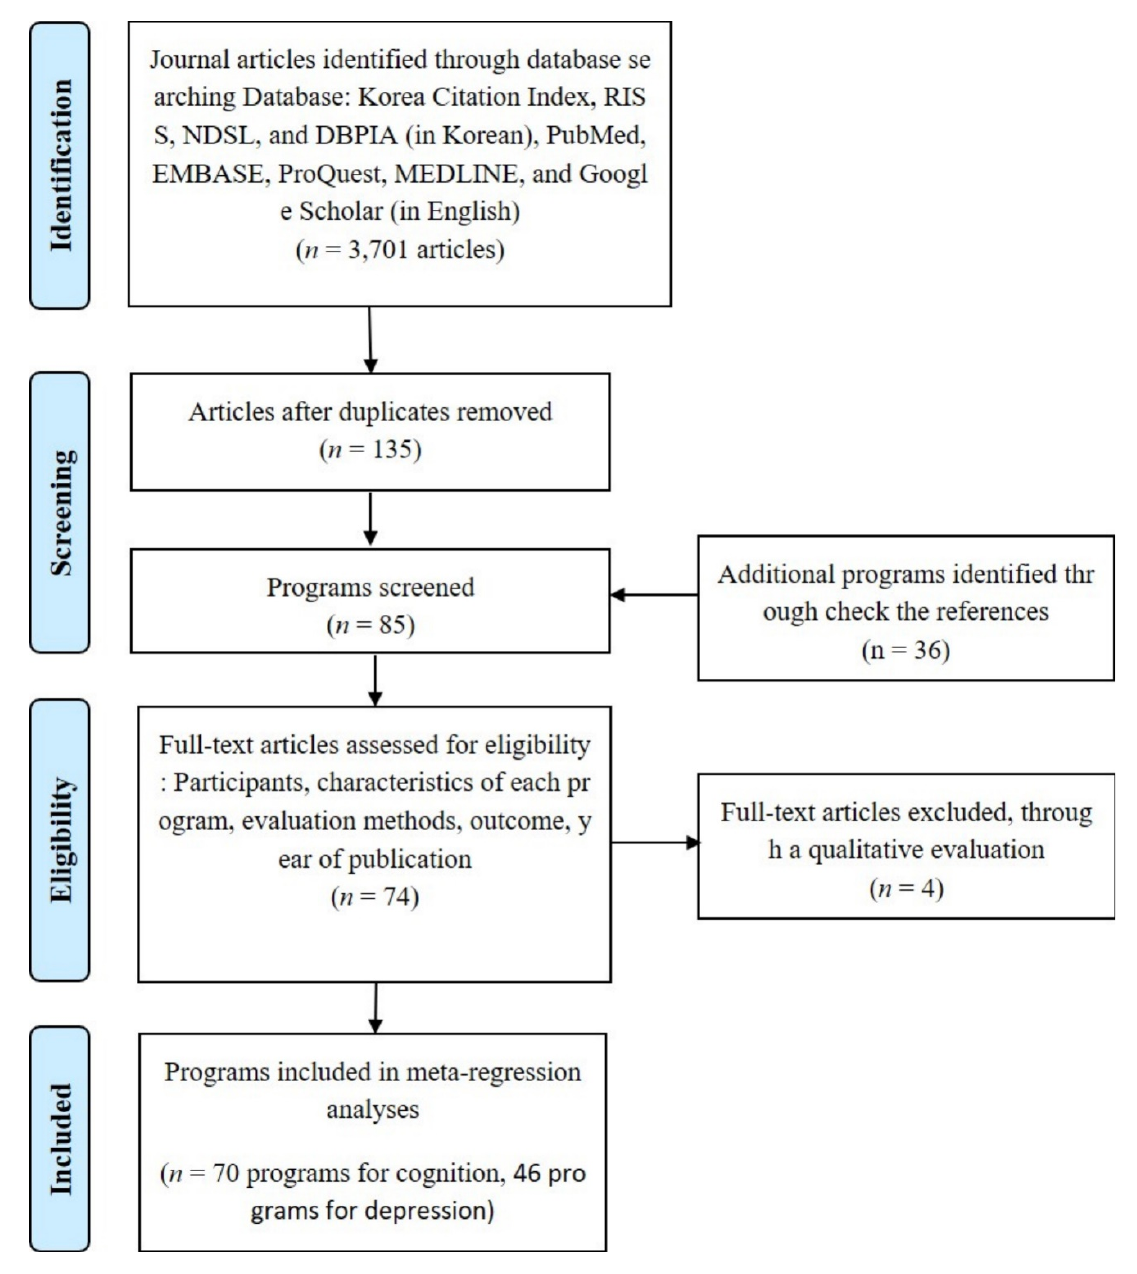
Figure 1. Flow diagram—data collection and selection process.